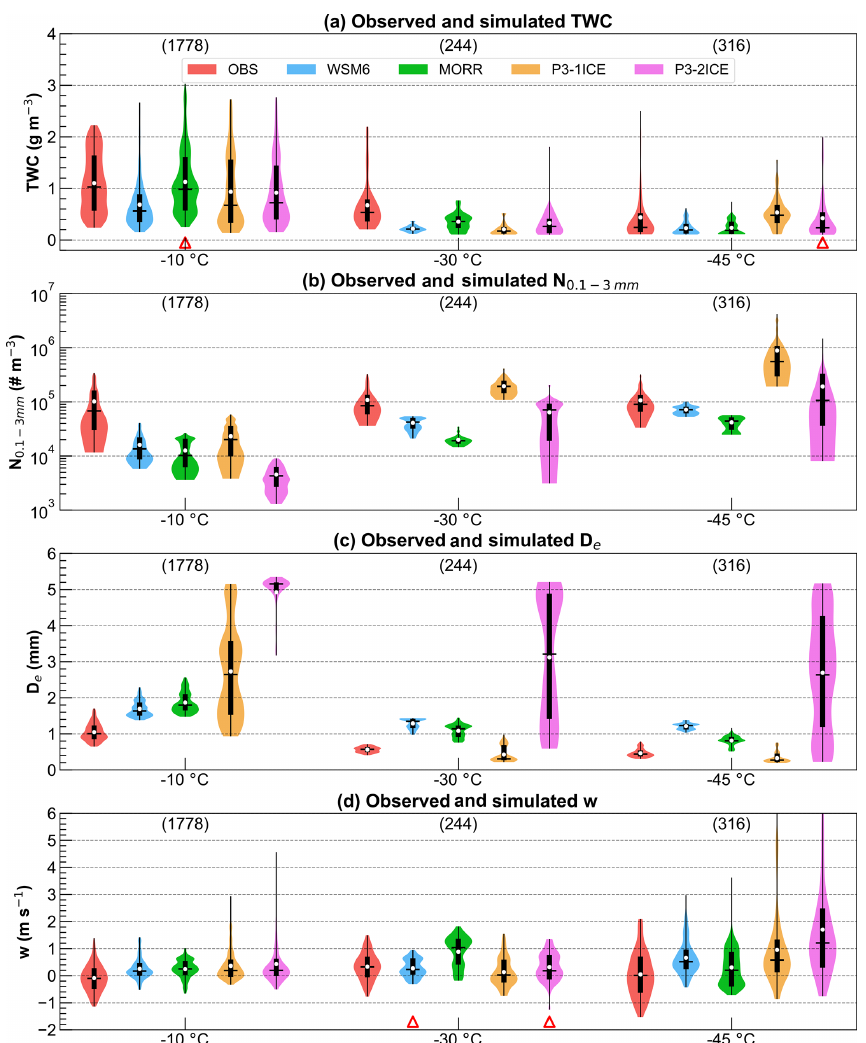
Figure 11. Violin plots of observed (red) and simulated (blue: WSM6, green: MORR, orange: P3-1ICE, magenta: P3-2ICE) (a) total water content (TWC, gm − 3 ), (b) number concentration (#m − 3 ) within 0.1mm < D max < 3mm ( N 0 . 1 − 3mm ), (c) effective diameter ( D e , mm), and (d) vertical velocity (ms − 1 ) at temperatures of − 10, − 30, and − 45 ◦ C. As for the black box-and-whisker plots, the extremes of the whiskers indicate the 5th and 95th percentiles, the lower and upper limits of the boxes correspond to the 25th and 75th percentiles, the dividing line represents the median value, and the white points represent the average value of samples between the 5th and 95th percentiles. The width of the shaded area represents the proportion of the data located there, and only areas between the 5th and 95th percentiles are shown. The numbers below the upper horizontal axis represent the total number of samples. The red triangles above the bottom horizontal axis indicate that the difference between the experiment mean and the observation mean is not statistically significant (not passing the significant test for p < 0 .